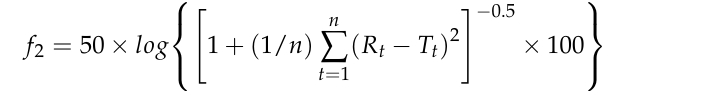
Table 5. Parameter estimates of the in vitro release model.